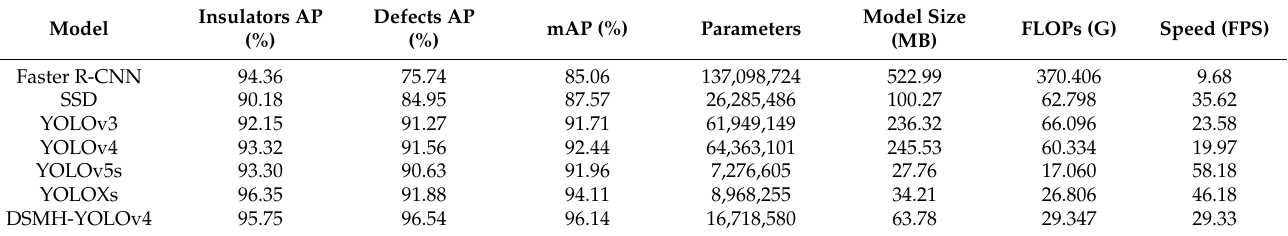
Table 1. Comparison of evaluation indicators of mainstream detection